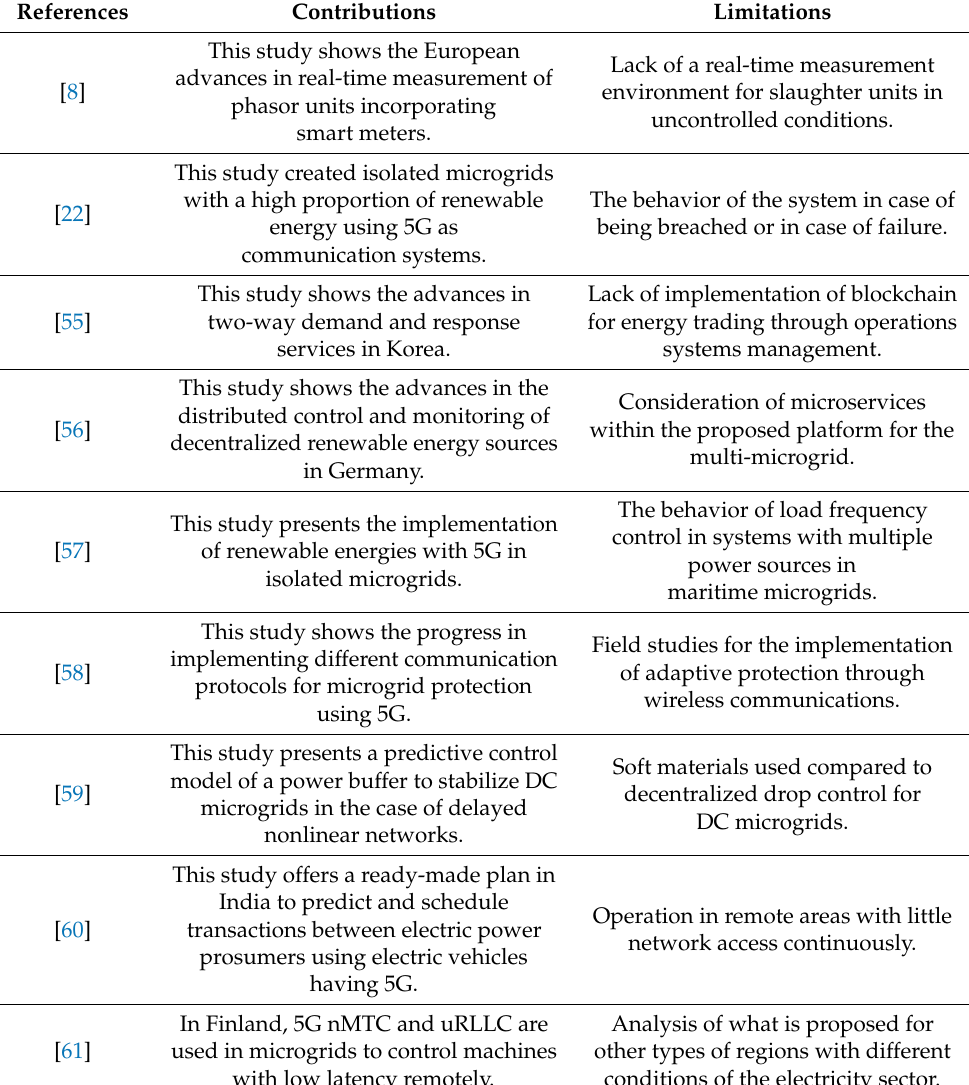
Table 1. Article contributions to 5G microgrid deployments and their